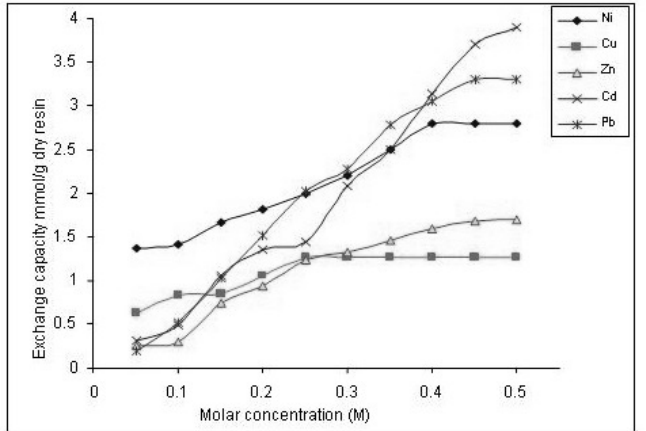
Figure 5 . Effect of concentration on metal ion exchange capacity on AFM